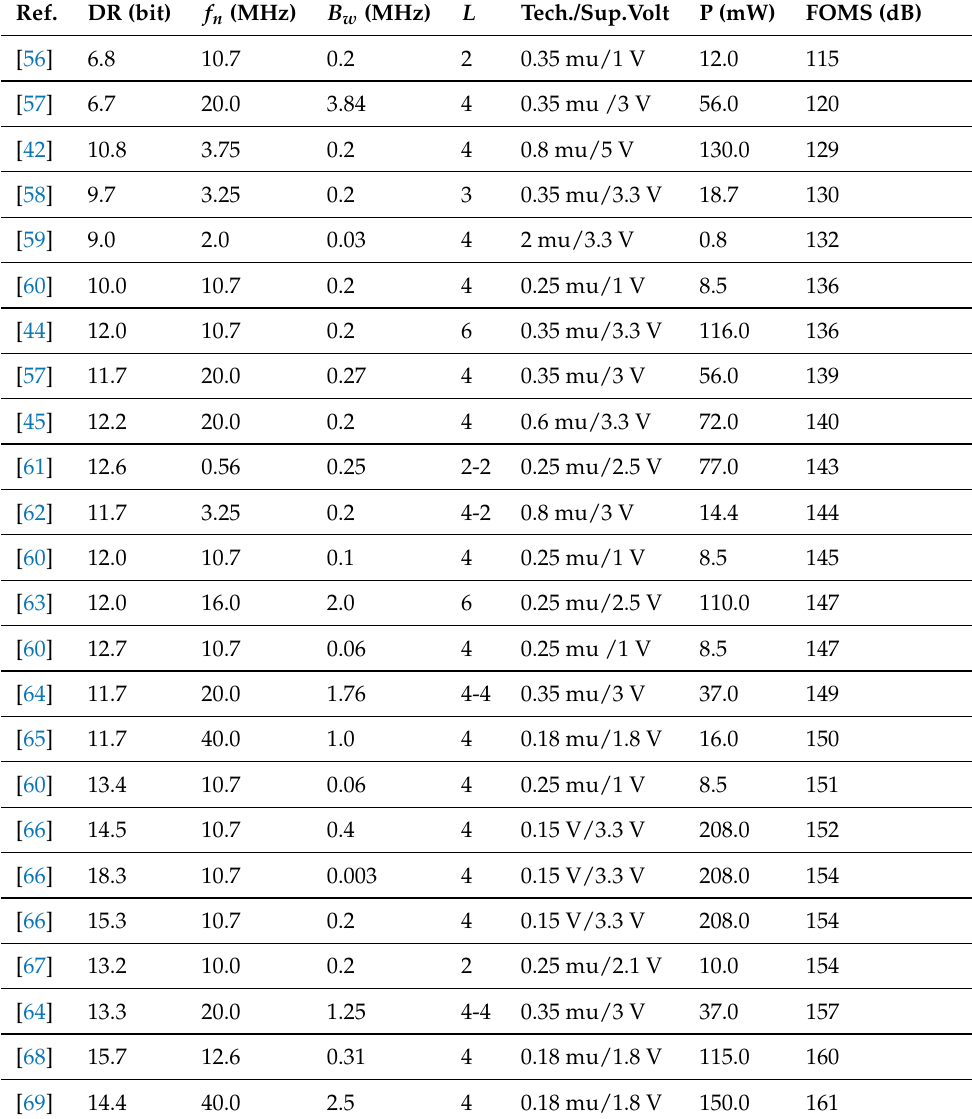
Table 1. Summary of the state of the art on SC BP- Σ∆ M ICs (sorted by FOMS).